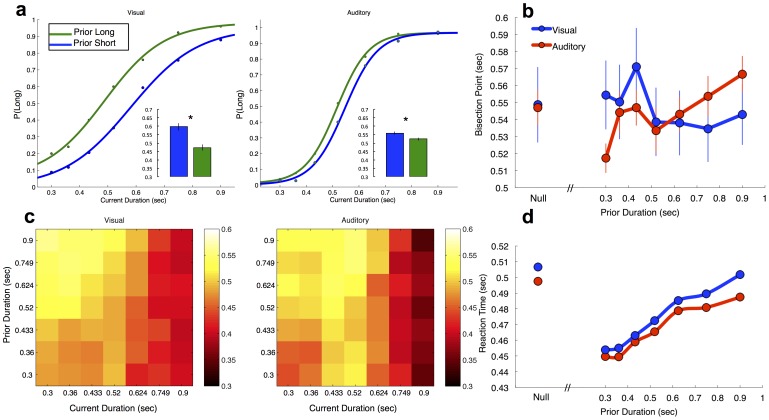
Carryover effects of duration.(a) Grand average psychometric curves for auditory and visual participants displaying the response for each duration on trials preceded by a response choice Long or Short. Insets display the average BP across participants for each prior choice condition; participants were more likely to classify an interval as long (or short) if the prior decision, independent of the prior interval, was classified as long (or short). Error bars indicate s.e. of the mean. Asterisks indicate significance at p<0.05. (b) Perceptual influence of the prior interval for visual and auditory participants. The far left point on each graph indicates the BP for the prior null condition; notably, the BP for the null prior condition was in the middle of the range of BPs observed for all prior duration conditions for both auditory and visual stimuli. Auditory participants exhibited a linear effect of prior interval, such that shorter prior intervals were associated with more leftward psychometric curves and smaller BPs, indicating a greater probability of categorizing stimuli as longer. No effect of prior interval was found for visual participants. (c) Response matrices displaying reaction time (RT) for every condition pairing. Slower RTs (hotter pixel colors) were found for shorter durations that were preceded by trials with longer durations. (d) RT data for each prior duration, averaged across current duration; both auditory and visual participants exhibited a strong linear effect of the prior duration.